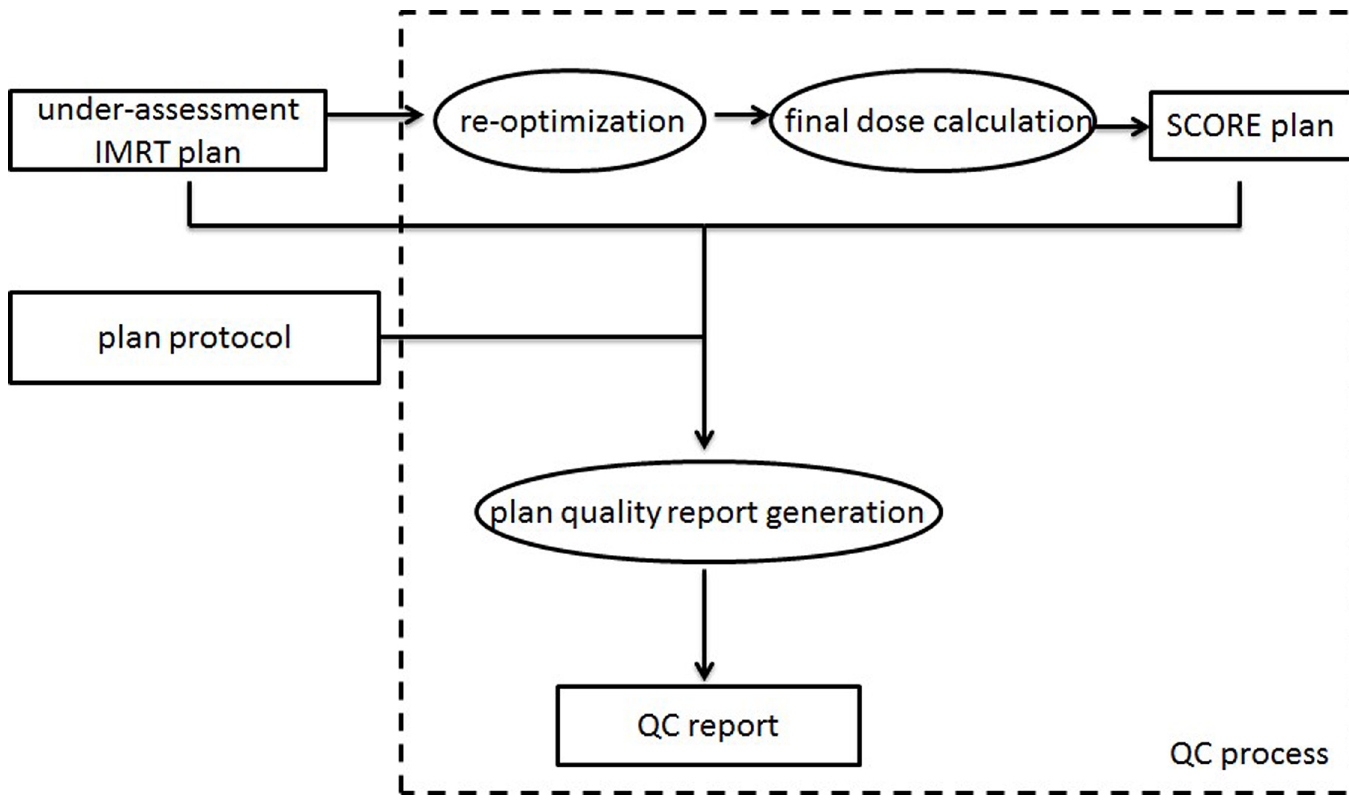
Fig 1. Workflow for the IMRT TPS-QC